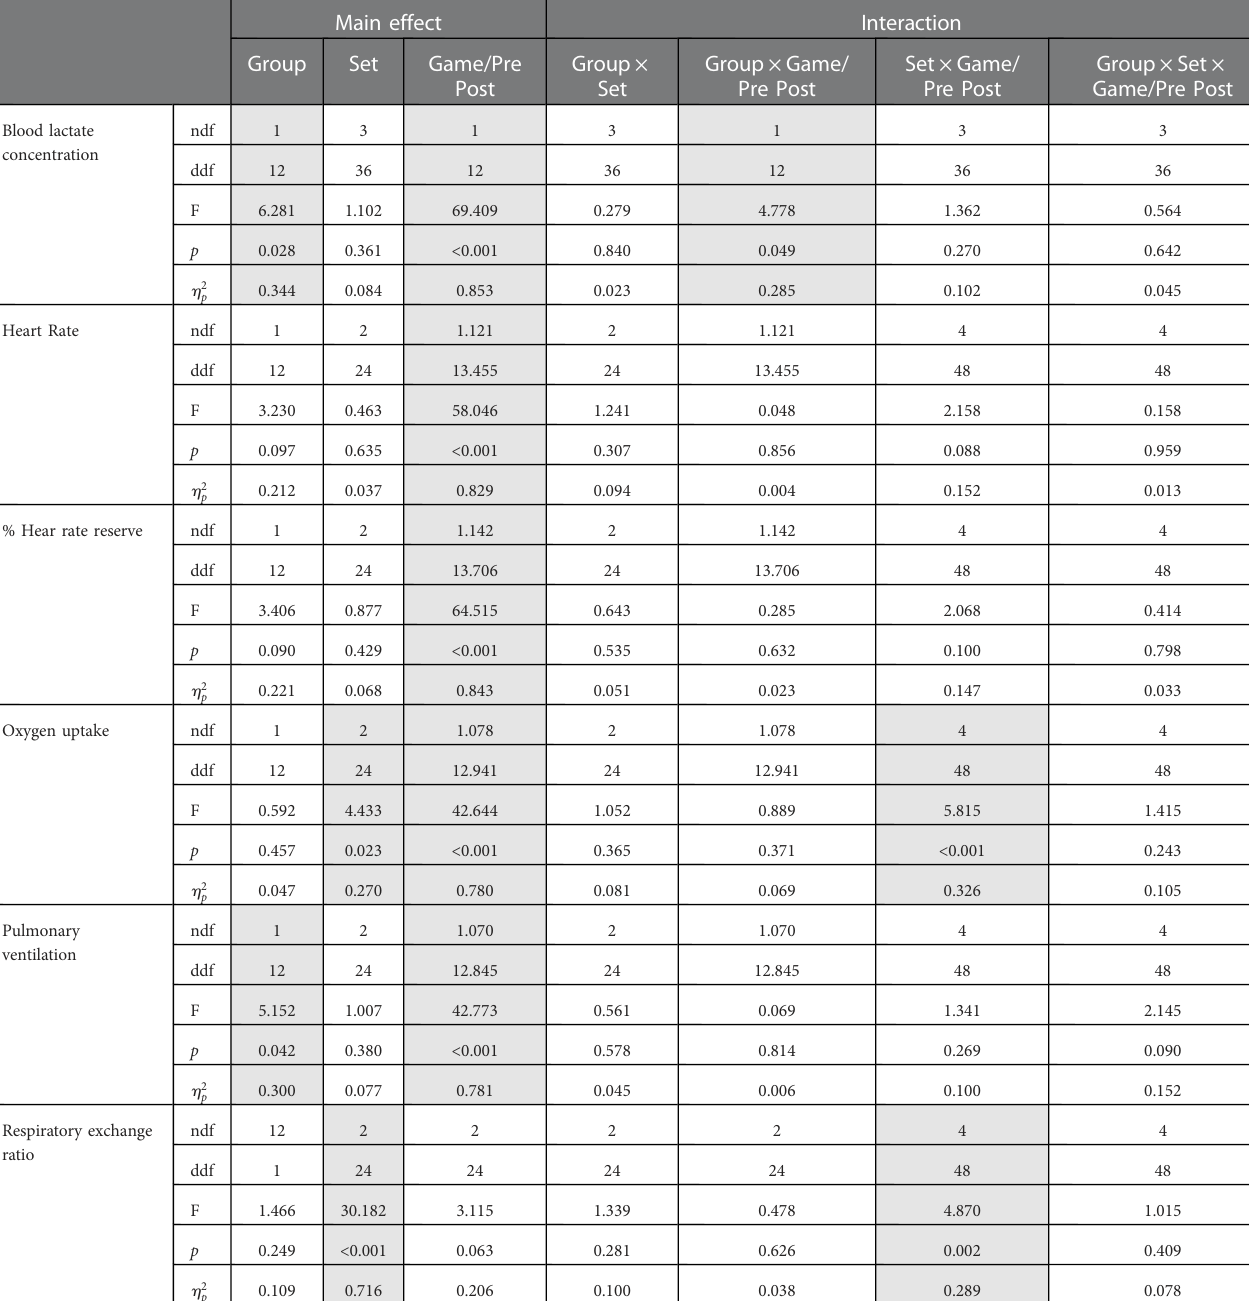
TABLE 1 Main effects and interactions of physiological